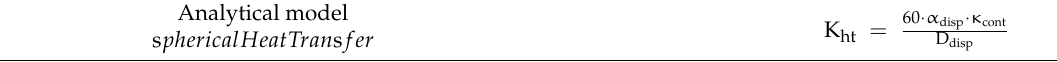
Table A2. Heat transfer coefficient implemented on OpenFOAM-v6. Analytical